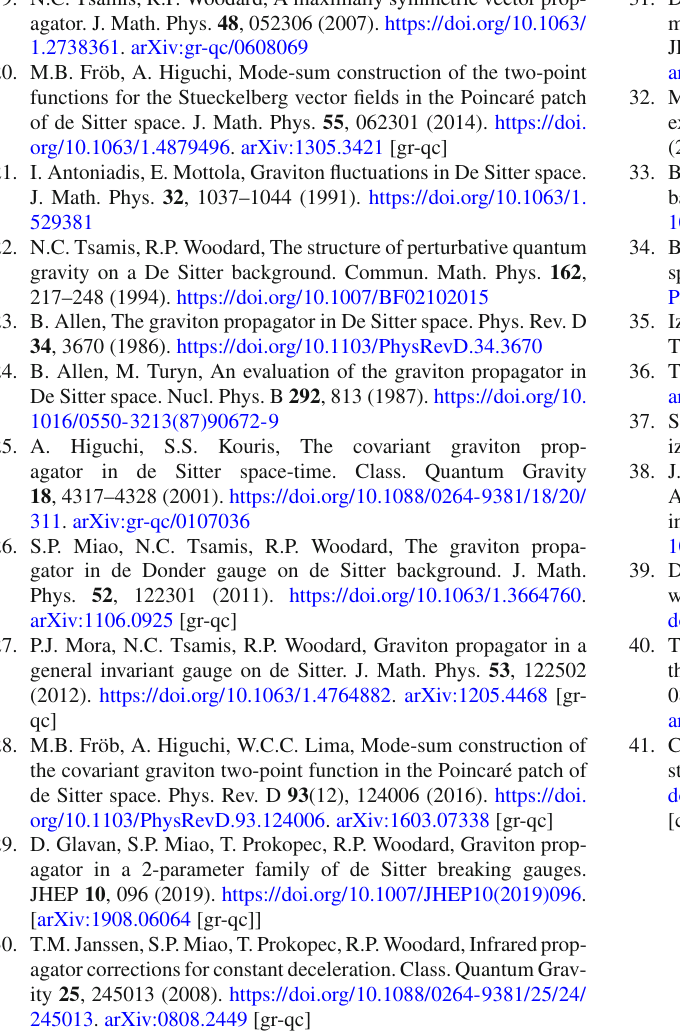
Table of integrals, series, and products (Academic Presss, 2014) 36. T. Hahn, Routines for the diagonalization of complex